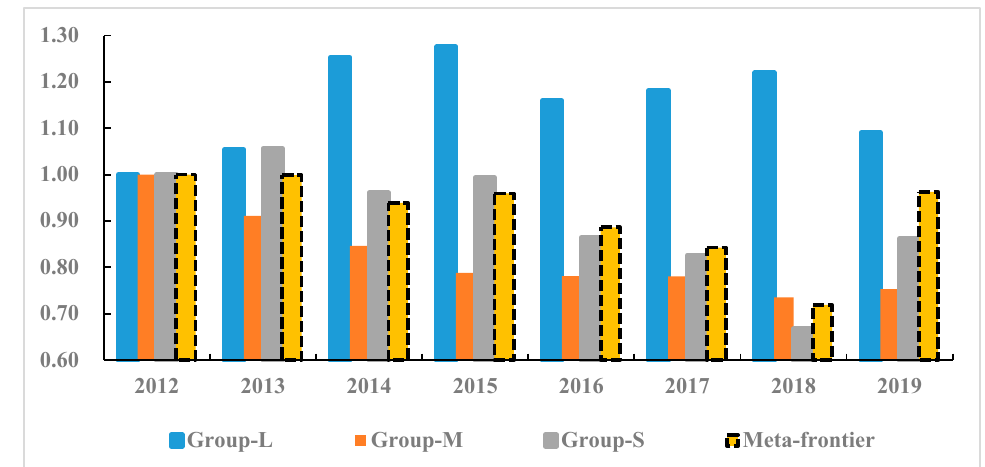
Figure 4. Time series changes in energy-use technology of the different groups during the period of 2012–2019.